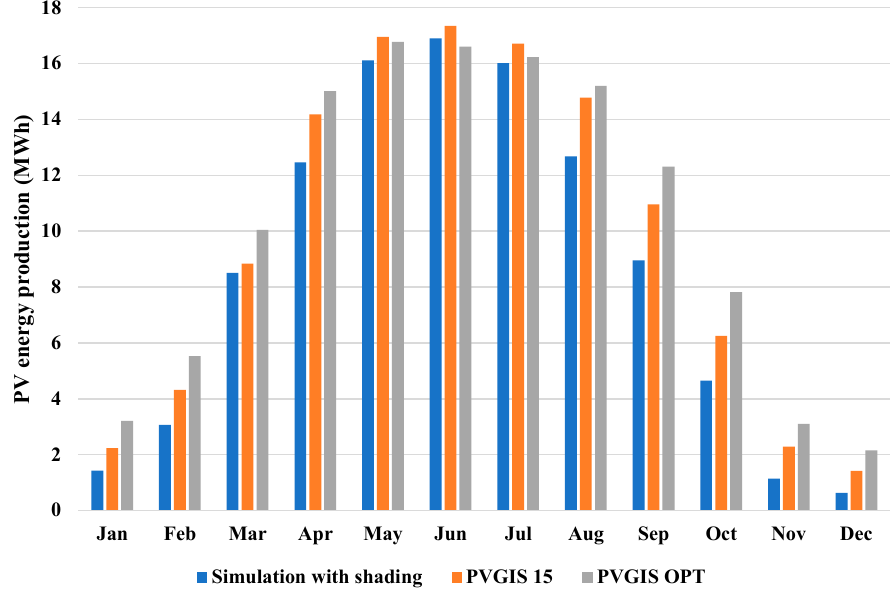
Figure 7. Comparison of monthly PV energy output between different simulations.